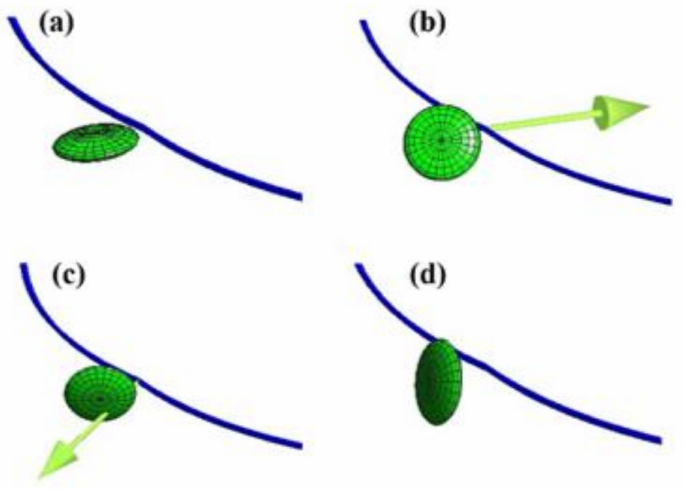
Figure 2. Dislocation interactions with different orientation of {111} plates. ( a ) Type-C: (111) plate parallel to slip plane, ( b ) Type-B: ( − 111) plate intersected by 60 deg., ( c ) Type-B: (1 − 11) plate intersected by 60 deg., ( d ) Type-A: (11 − 1) plate intersected by 0 deg. Arrow indicating interaction force acted on the dislocation nodal point. Direction of dislocation motion under external stress is from upper right to lower left. Interaction forces are absent in ( a , d ), while strong interaction forces with opposite directions in ( b , c